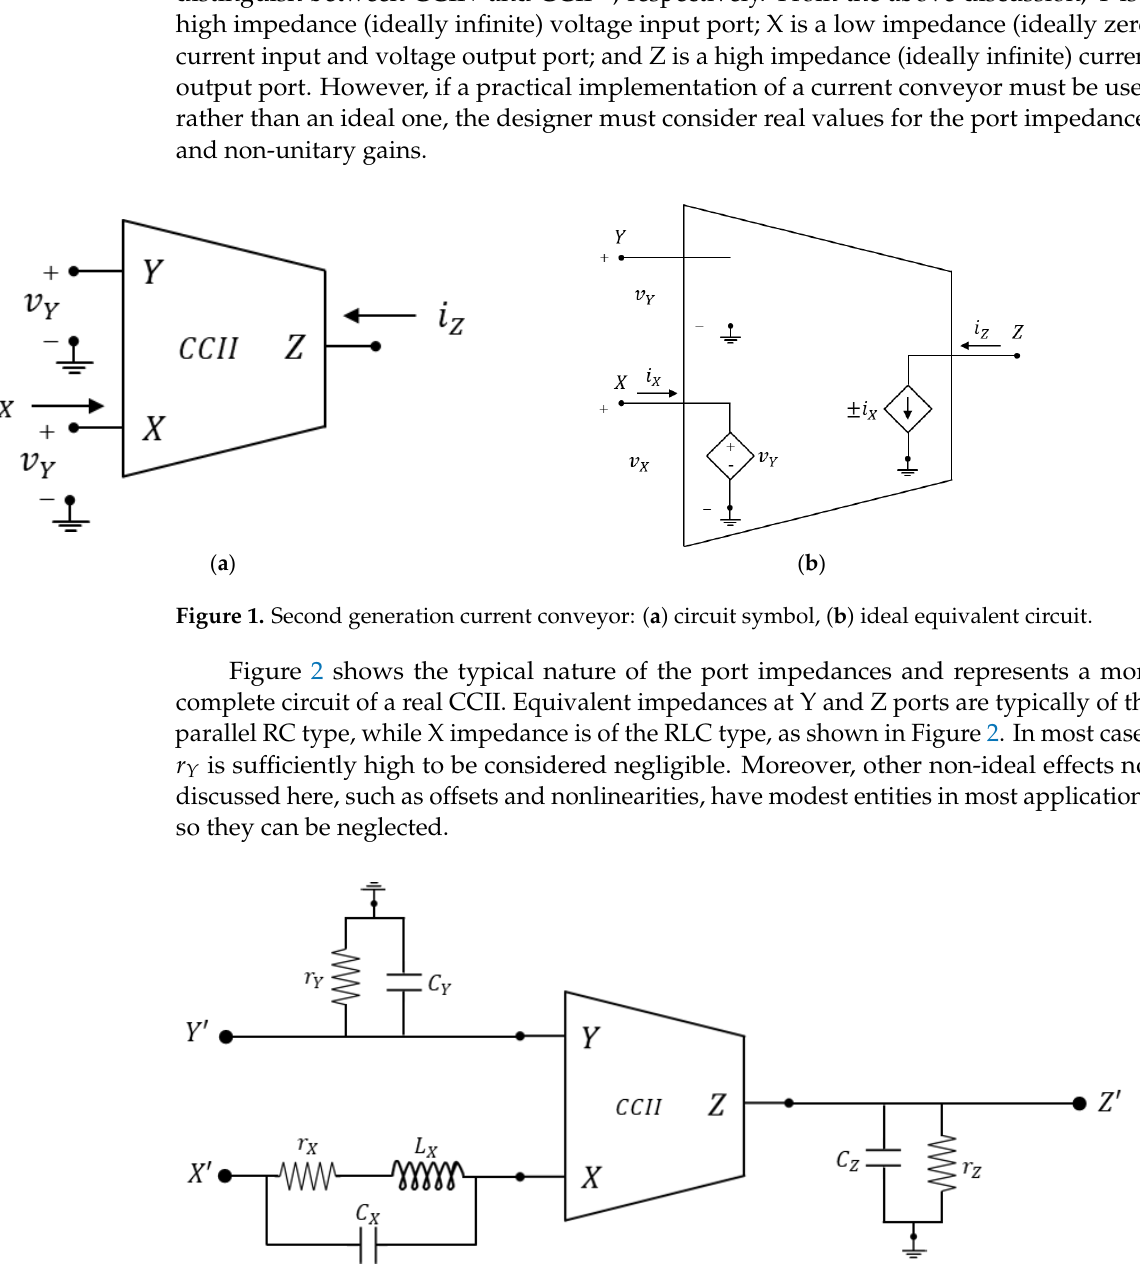
Figure 2. Real second-generation current conveyor.